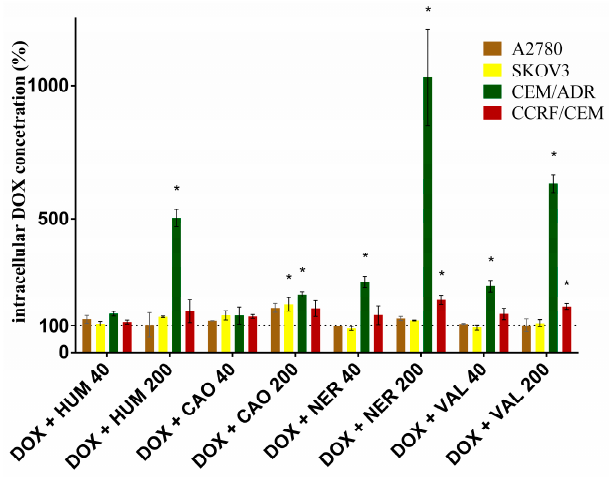
Figure 5. Effect of sesquiterpenes (40 and 200 µ M) on intracellular DOX concentration. Data presented DOX intracellular concentration (in percentages), with DOX alone serving as control (100%). The colored bars represent the mean ± S.D. calculated from 3 independent measurements. The asterisk indicates a significant difference from the control cells ( p < 0.05).